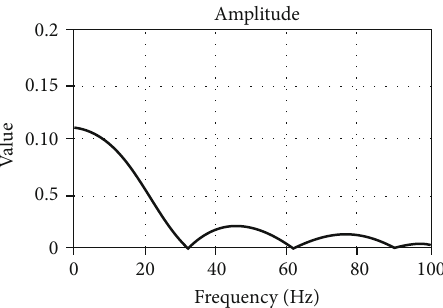
Figure 2: The amplitude of the 50-meter thick transition zone as a function of frequency, the plot obtained by the Equation